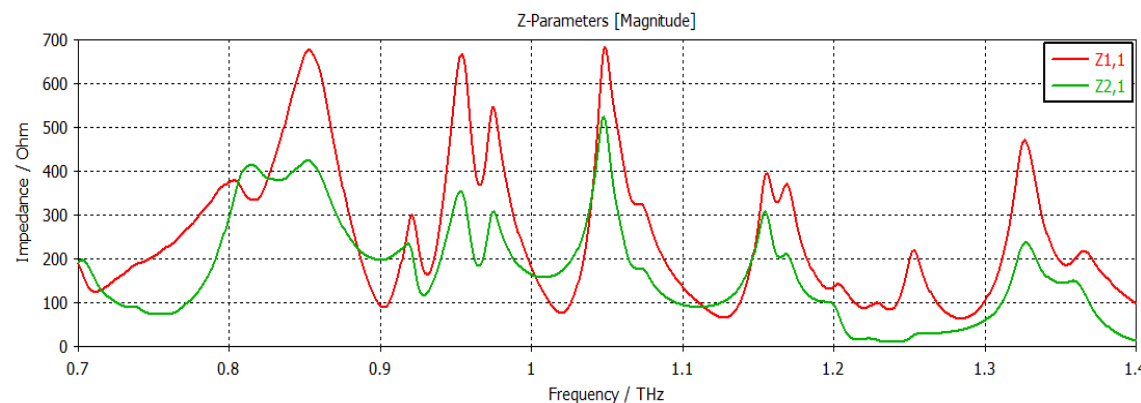
Figure 5. Impedance plot.